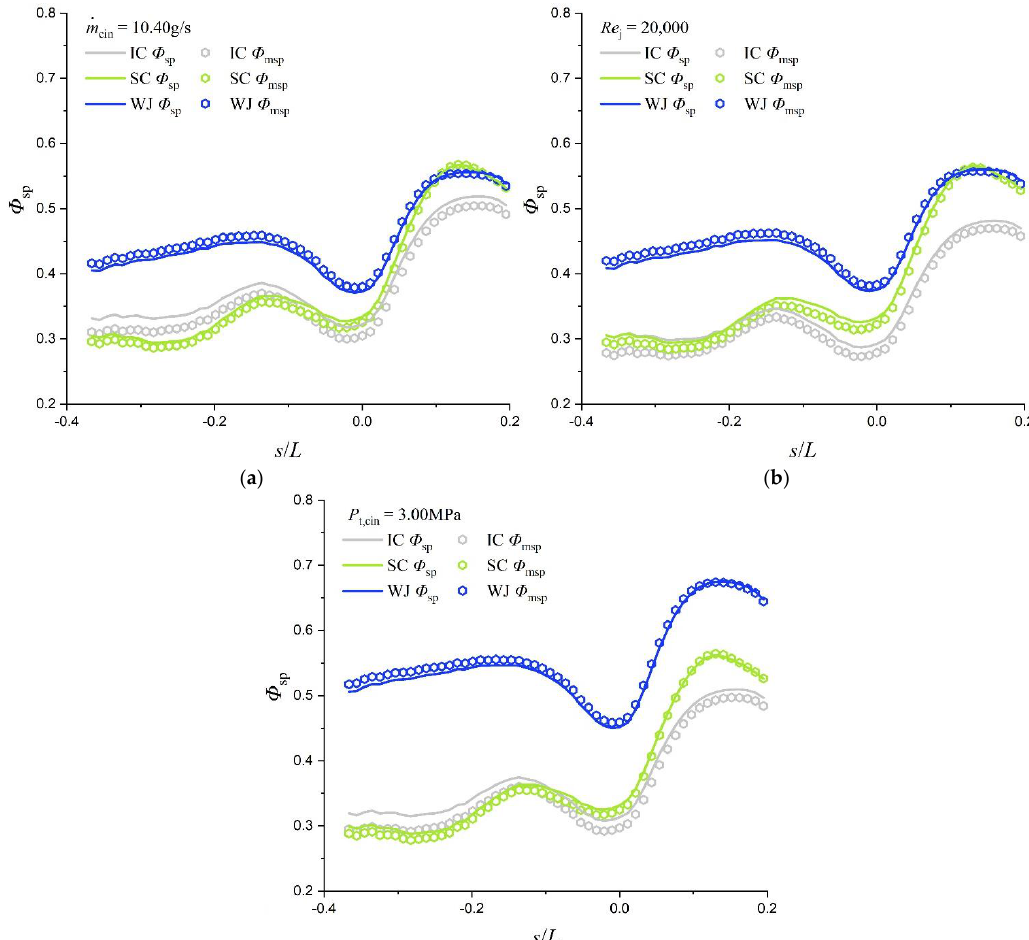
Figure 17. Span-wise averaged overall cooling effectiveness around blade leading edge with three cooling structures; ( a ) Cases with the same m ̇ cin ; ( b ) Cases with the same Re j ; ( c ) Cases with the same three cooling structures; ( a ) Cases with the same P t,cin . same P t,cin